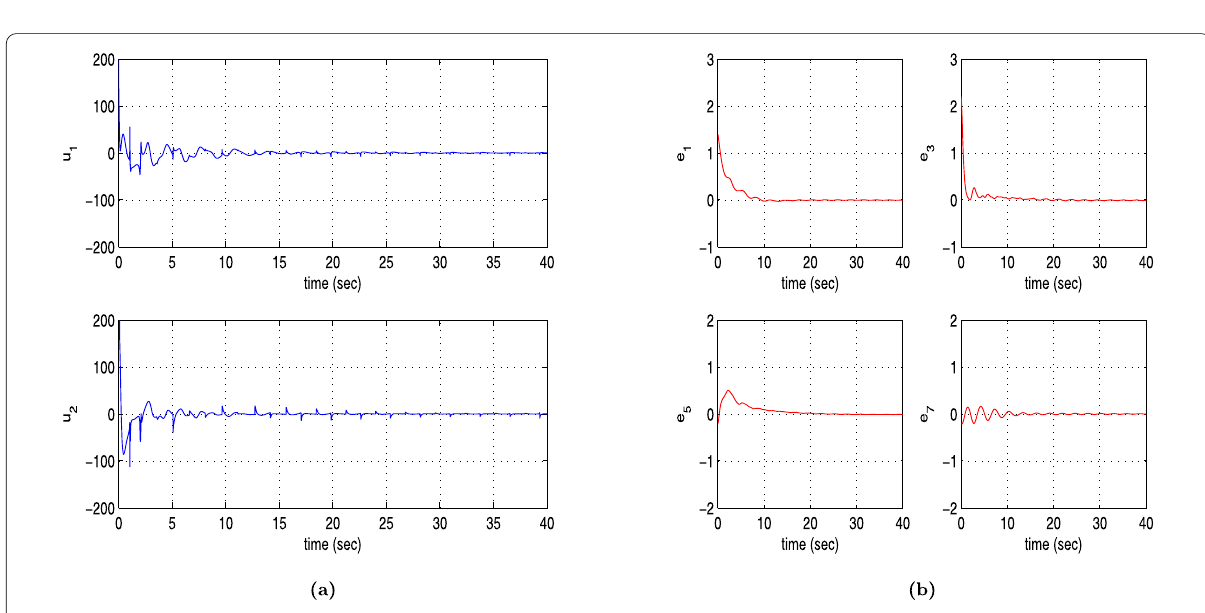
Figure 8 Tracking of setpoint 3 for the tower crane ( a ) control inputs u 1 , u 2 applied to crane, ( b ) tracking error variables e 1 , e 3 , e 5 , e 7 of the tower